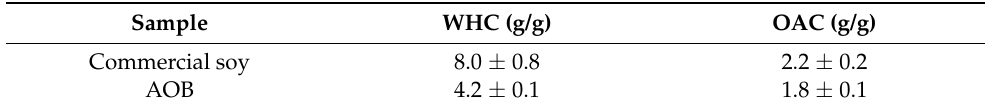
Table 3. Water holding capacity (WHC) and oil adsorption capacity (OAC) of commercial soy and AOB protein isolates.